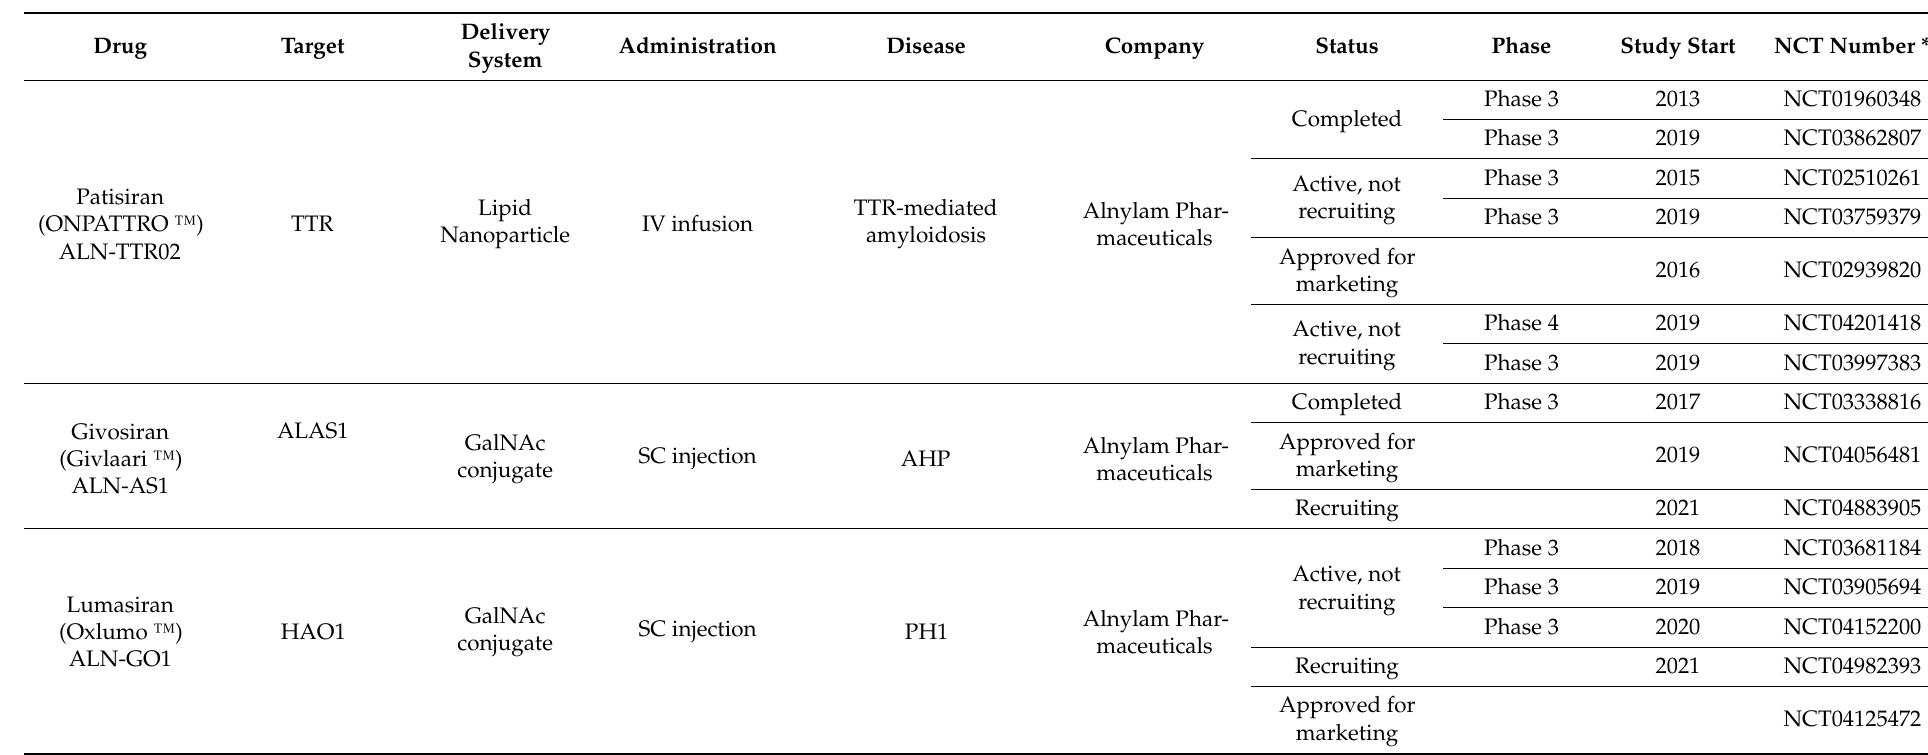
Table 1. Clinical studies of siRNA